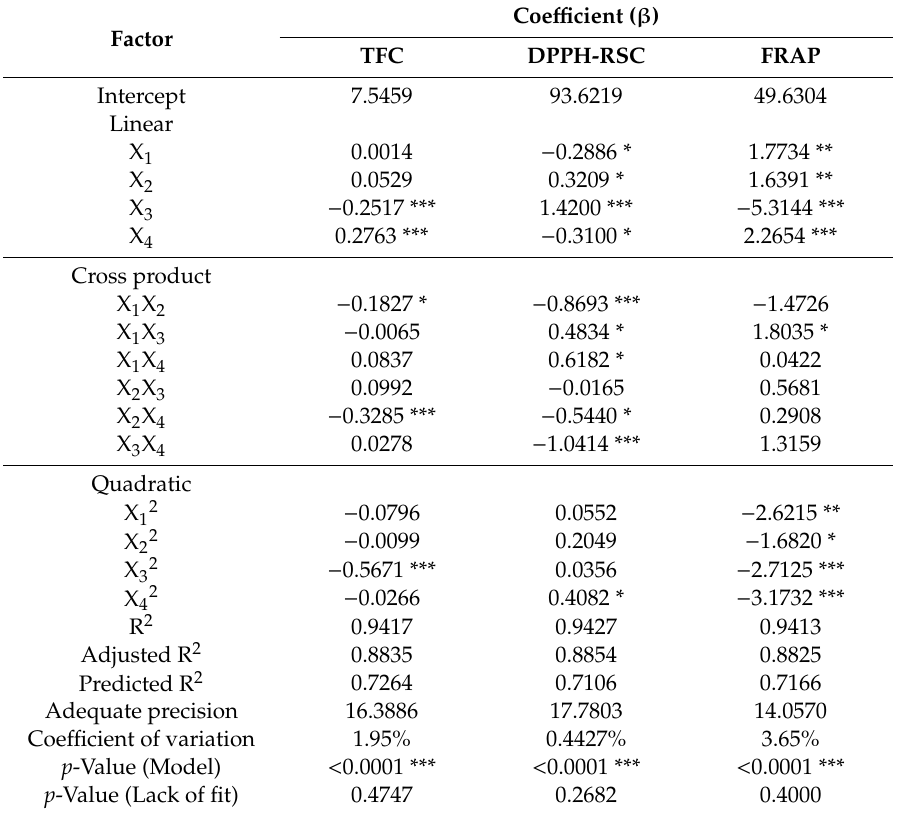
Table 2. Regression coe ffi cient ( β ) and fit statistics of the predicted second-order polynomial models for flavonoids and antioxidant